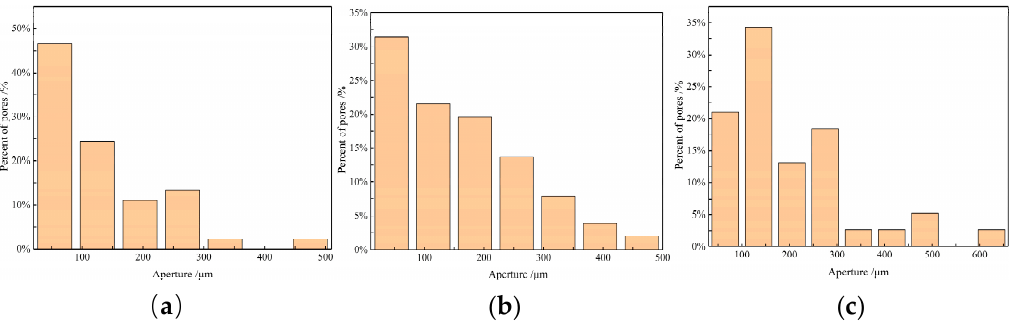
Figure 12. The histogram of the aperture distribution for the different samples. ( a ) S2; ( b ) S3; ( c ) S4.